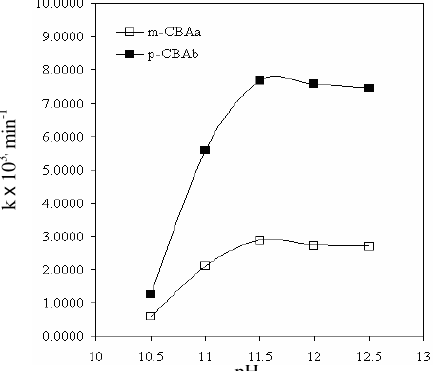
Figure 3. Effect of pH m -CBA with time [ p -CBA] = 4.0 x 10-5 M, a[2-Naphthol] = 2.0 x 10 -5 M, b[2- Naphthol] = 2.5 x 10 -5 M, light intensity= 11.8 x 10 -8 E sec-1, pH = 11.5, Temperature = 298